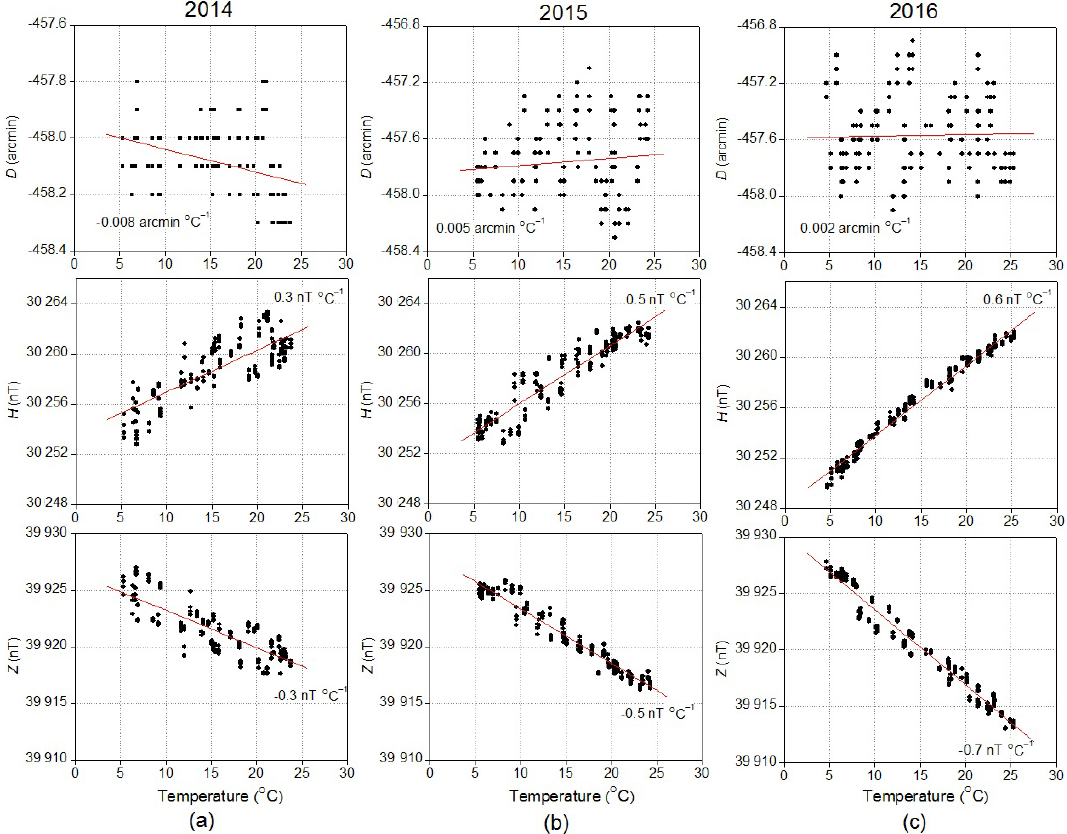
Figure 9. Temperature coefficient of D , H and Z baselines for (a) 2014, (b) 2015 and (c)